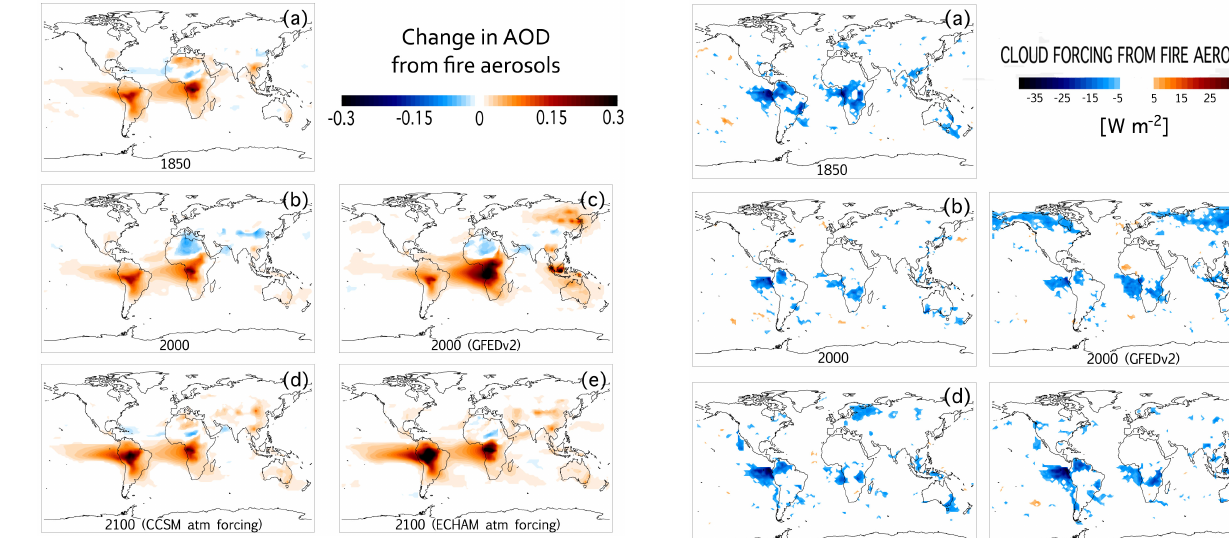
2 Fig. 7. The annual average change in total cloud forcing from fire aerosols for a) 1850 CLM3 fires, b) 3 Fig. 7. The annual average change in total cloud forcing from fire 2000 CLM3 fires, c) 2000 GFEDv2 fires, d) 2100 CLM3 fires with CCSM atmospheric forcing, and e) 4 aerosols for (a) 1850 CLM3 fires, (b) 2000 CLM3 fires, (c) 2000 2100 CLM3 fires with ECHAM atmospheric forcing. Note that values between -5 W m -2 and 5 W m -2 5 GFEDv2 fires, (d) 2100 CLM3 fires with CCSM atmospheric forc- are not plotted. 6 ing, and (e) 2100 CLM3 fires with ECHAM atmospheric forcing. Note that values between − 5Wm − 2 and 5Wm − 2 are not